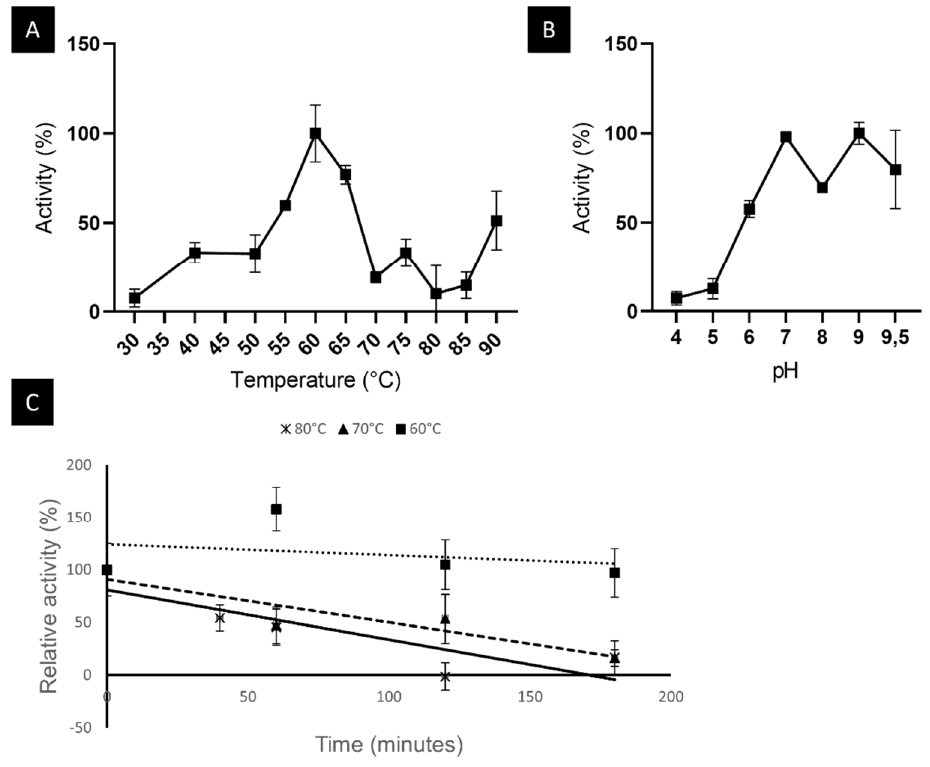
Figure 5. Biochemical characterization of LipB12_A11. ( A ) Optimal temperature for LipB12_A11. 100% activity is 1.58 × 10 − 5 U/µL. ( B ) Optimal pH for LipB12_A11. The 100% activity is 8.70 × 10 − 6 U/µL. ( C ) Thermostability of LipB12_A11. The 100% activity is 9.42 × 10 − 6 U/µL. Solid line: 80 °C linear regression; intermittent line: 70 °C linear regression; dotted line: 60 °C linear regression.